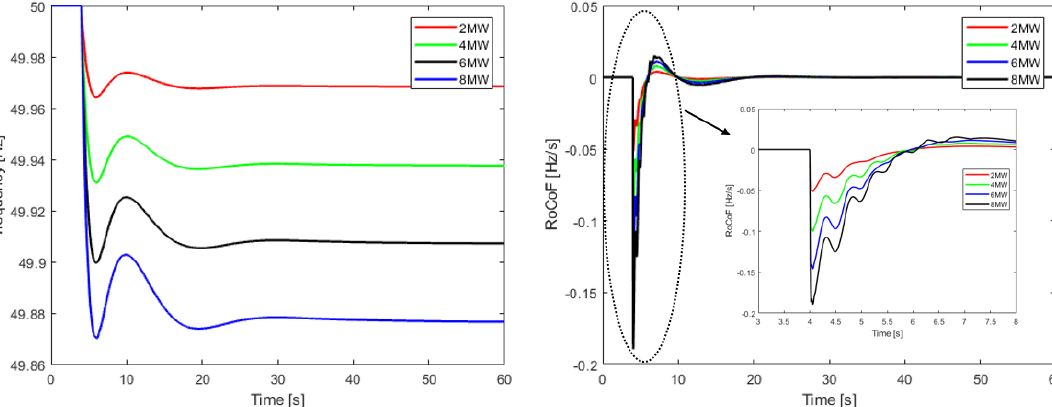
Figure 11. Load step-change frequency response and RoCoF for the future best case with the BESS installation.